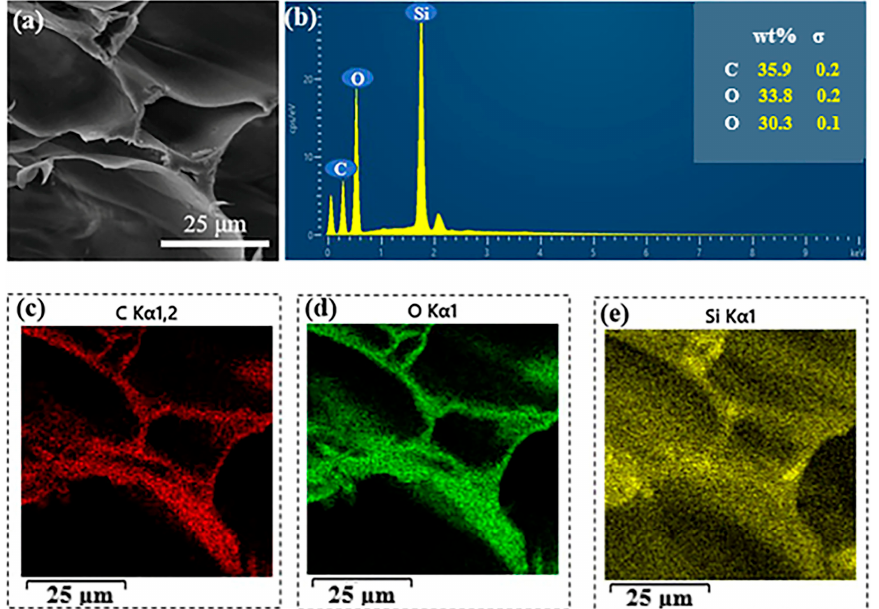
Figure 4. ( a ) SEM image of the DW/Si-10 aerogel, ( b ) Element (C, O, Si) content of the DW/Si-10 aerogel, ( c ) C, ( d ) O, and ( e ) Si EDS spectrum of the DW/Si-10 aerogel. The surface chemistry of the composite was confirmed using FT-IR spectroscopy (Figure 3b). In addition to the typical DW peaks, the peak at 1080 cm − 1 was attributed to the asymmetric stretching vibration of Si-O-Si, and the characteristic peak at 800 cm − 1 cor- responded to the Si-O-Si symmetric stretching vibration, further stipulating and indicat- [27,28]. In the case of silica aerogels, the characteristic peak of Si–OH was located at 920 cm − 1 , whereas the Si–OH characteristic peak of the wood–silica aerogels red-shifted to 895 cm − 1 . A red shift designates a decrease in the bond energy; thus, the results indicate that Si–OH generated hydrogen bonds with the − OH groups on the surface of the wood skel- eton. Figure S2 shows the X-ray diffraction (XRD) patterns of the NW, DW, and DW/Si-10 aerogels. The XRD patterns exhibited characteristic diffraction peaks of (101), (002), and (040) at 2 θ = 17°, 22.5°, and 35°, respectively [29]. With the introduction of silica aerogel, the positions of the wood cellulose diffraction peaks were invariable, which shows that